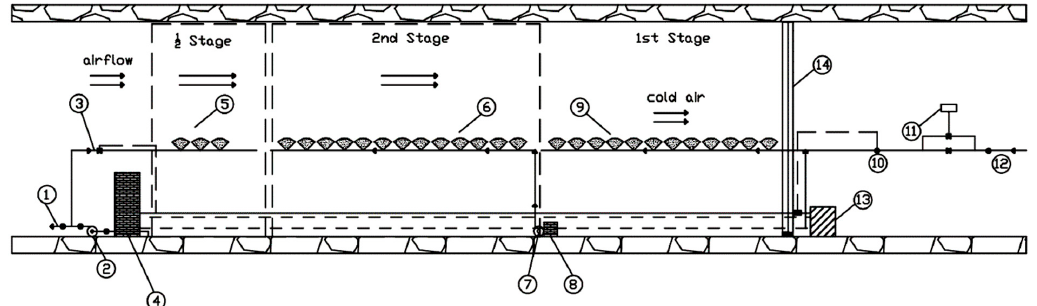
Figure 2. A typical horizontal BAC (modified and reprinted from) [25]. 1—Return pipeline,